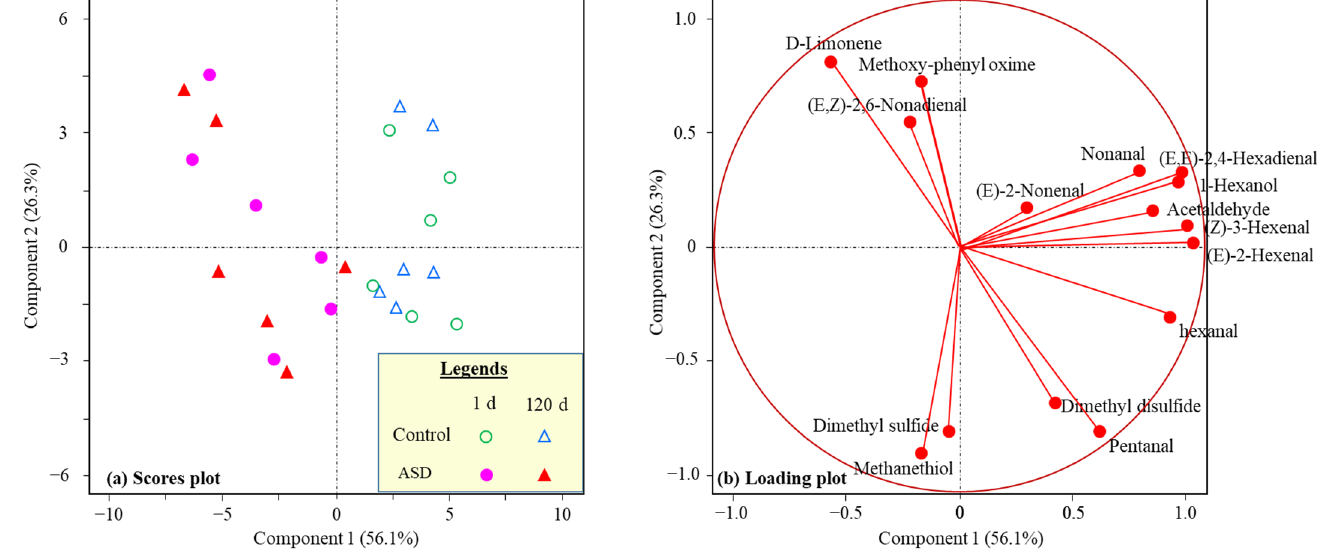
Figure 4. Principal component analysis (PCA) of 16 volatile compounds in winter melon juice samples extracted from ASD treated or control fruit that were stored at 20 °C for 1 or 120 d. ( a ) Scores plot and ( b ) Loading plot.